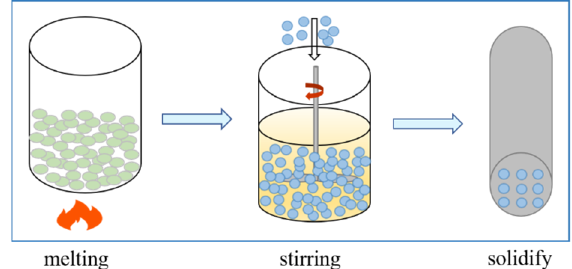
Figure 1. Typical preparation processes of PCMs.